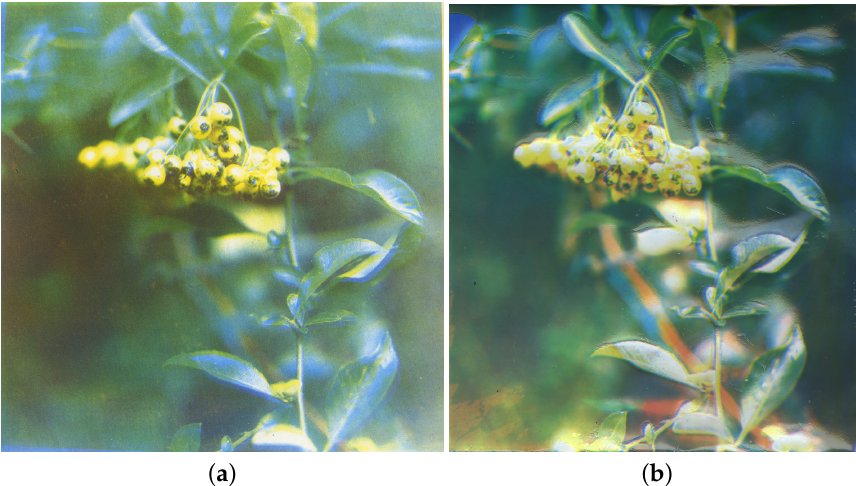
Figure 4. Scans of a test image, printed using both ( a ) traditional lithography techniques and ( b ) the Woodburytype process. The Woodburytype image is built using the method defined in the text, from a three-component CMY print process. It displays a similar level of clarity, definition and colour range to the well-documented lithography method, despite being a two-dimensional representation of an image with physical variation in depth.